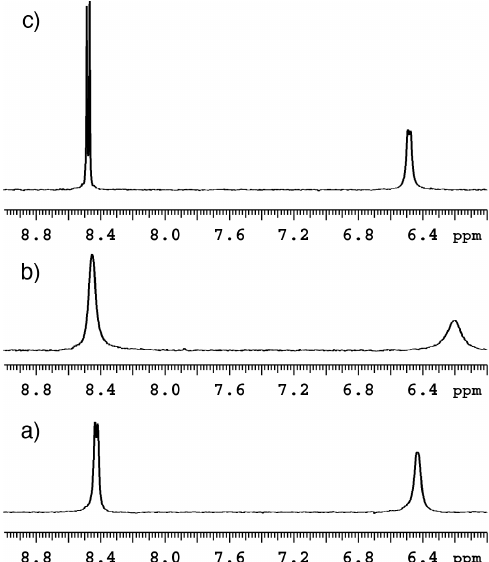
Figure 5. 1 H NMR spectra of NC0 β CD ; ( a ) alone and in the presence of ( b ) 1-AdOH or ( c ) UDCA showing the region of the NBD protons; [ NC0 β CD ] = [ 1-AdOH ] = [ UDCA ] = 5 × 10 − 4 M (Adapted from [20] with permission from the Royal Society of